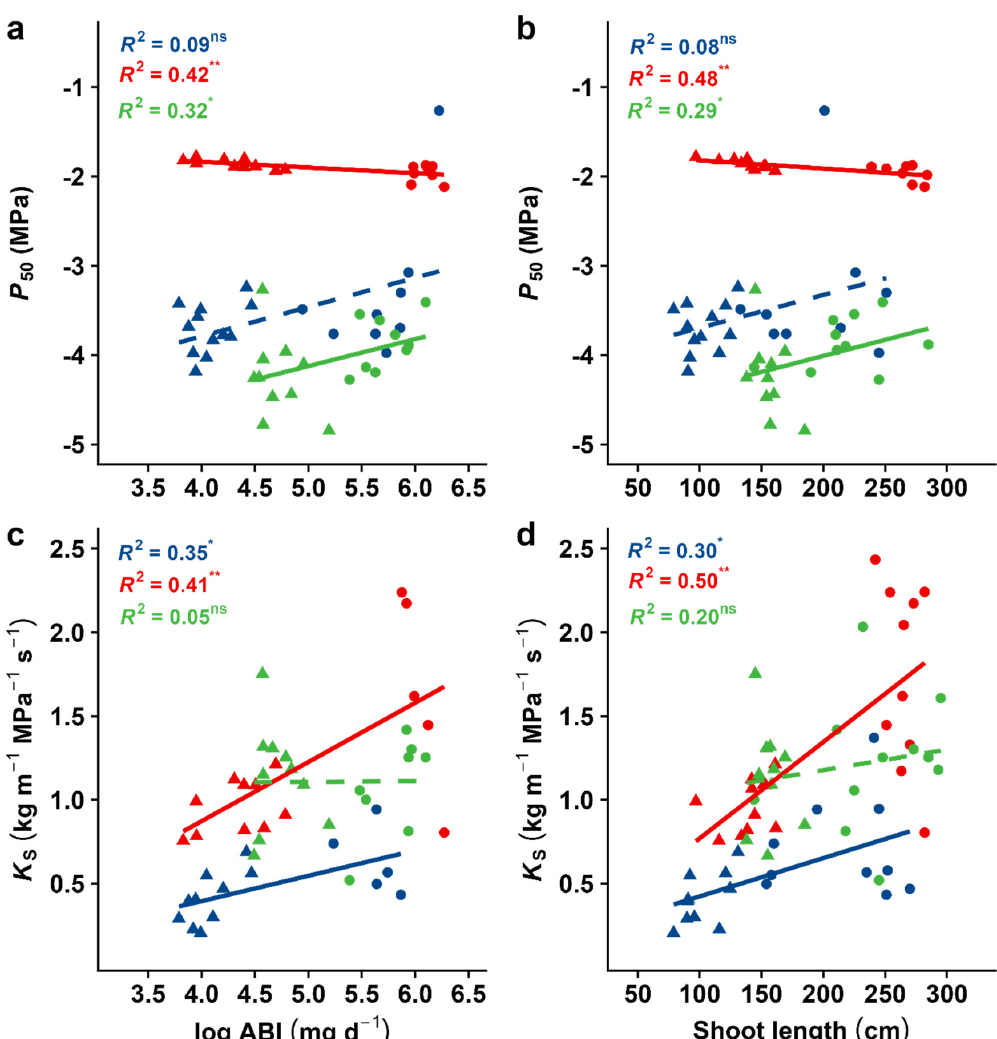
Figure 4. Effect of growth performance on the water potential at 50% loss of hydraulic conductivity ( P 50 ) and specific conductivity ( K S ). Given are linear regression analyses between ( a ) P 50 or ( c ) K S and log-transformed growth rate, and ( b ) P 50 or ( d ) K S and shoot length. Indicated for each species are the coefficients of determination, i.e., R-squared, for the investigated relationships. Different colours and symbols represent different species and treatments (blue: A. pseudoplatanus ; red: B. pendula ; green: S. aucuparia ; filled circles: control treatment; triangles: stress treatment). Full lines indicate significant effects of variable x on variable y; dashed lines indicate a non-significant relationship. Asterisks indicate the level of significance ( *, p < 0.05; **, p < 0.01; ns, for non-significant).